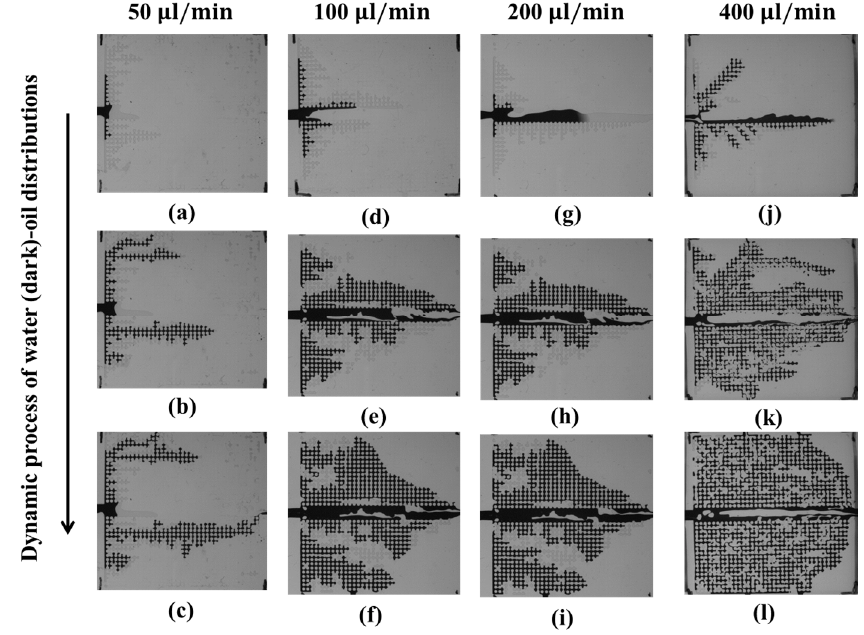
Figure 11. Dynamics of the water (dark)–oil (transparent) distributions during the imbibition process at water-injection rates of 50 µ L/min ( a – c ), 100 µ L/min ( d – f ), 200 µ L/min ( g – i ), and 400 µ L/min ( j – l ) in a micromodel. ( a , d , g , j ) correspond to the beginning; ( b , e , h , k ) to the middle; and ( c , f , i , l ) to the end of the imbibition process.